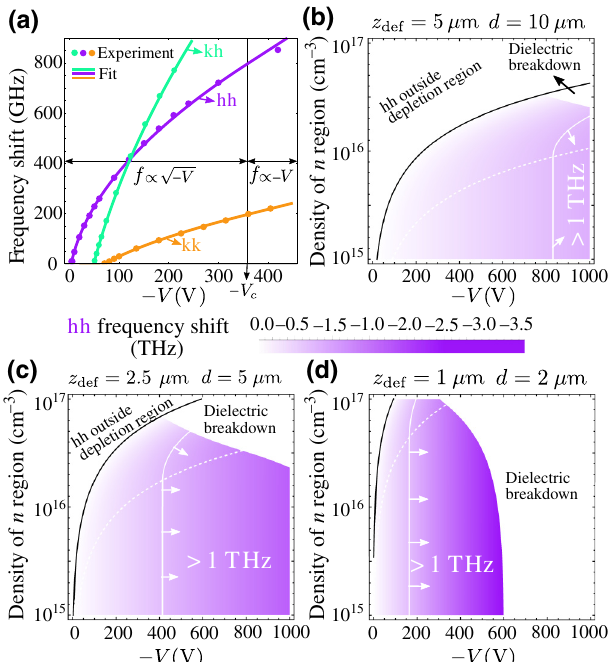
FIG. 3. (a) Fit for the frequency shift versus voltage V for the (cid:22) (cid:22) (cid:23) (cid:23) (cid:22) (cid:22) (cid:2) and (cid:2) (hh) and (kk) transitions and for → | T → | T E y E 1,2 ± (cid:22) (cid:22) (cid:24) (cid:24) 0 (cid:22) (cid:22) → (cid:22) ˜ A (cid:22) A (cid:5) (kh) transition assuming N = 4 × 10 15 cm − 3 . the 0 0 Frequency shift of the (hh) defect as a function of the volt- age and density of the n region for (b) z def = d / 2 = 5 μ m, (c) z def = d / 2 = 2.5 μ m, and (d) z def = d / 2 = 1 μ m. The black line delimits the parameter region in which the defect is placed inside and outside the depletion region. The solid white line represents a 1-THz frequency shift, and the dashed white line represents the change from p - n to p - n - n + diode